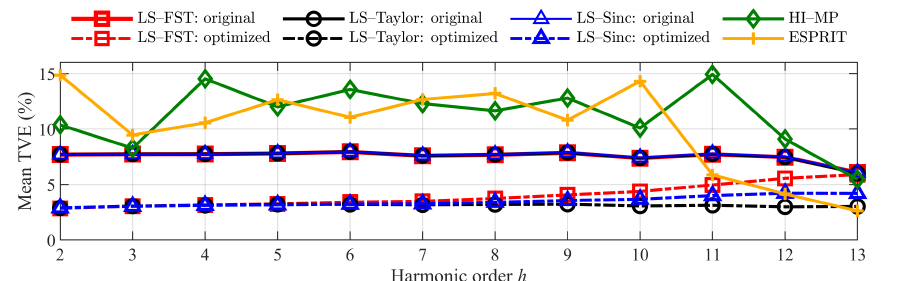
Figure 6. The mean TVE of LS-FST, LS-Taylor, and LS-Sinc with and without the proposed optimiza- tion, as well as the HI-MP and ESPRIT methods under harmonic amplitude